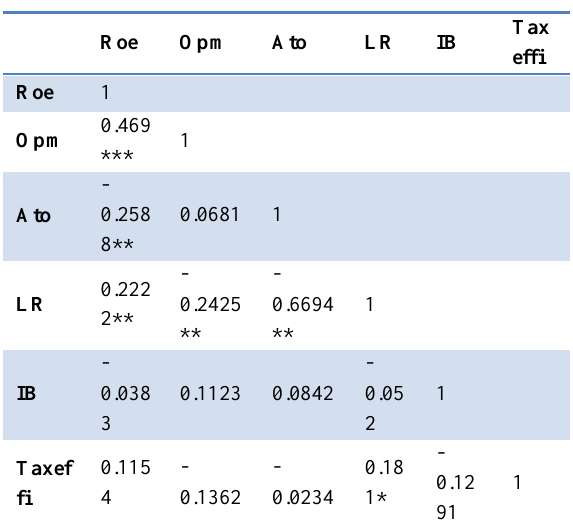
Table 3 Pearson Correlation Matrix During Profit Decline Periods